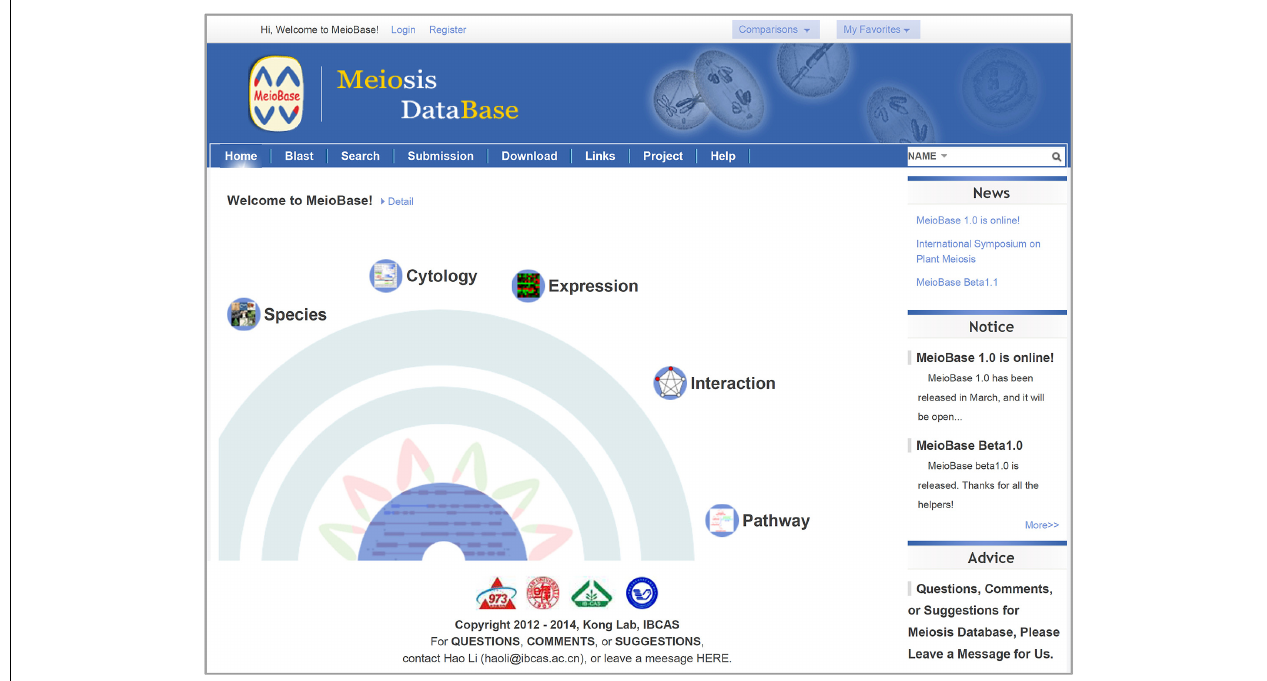
FIGURE 1 | Screenshot of MeioBase homepage.